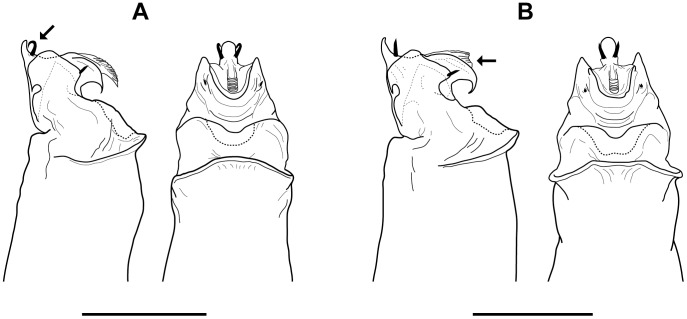
Comparative penis morphology for S. speoventus and S. steinmanni.A) lateral and ventral views, S. speoventus, paratype (Cave of the Winds, CO), arrow indicates curved subapical spines. B) lateral and ventral views, S. steinmanni, holotype (Mallory Cave, CO), arrow indicates dorsoventrally compressed ventral plate. Scale bars = 0.25 mm.